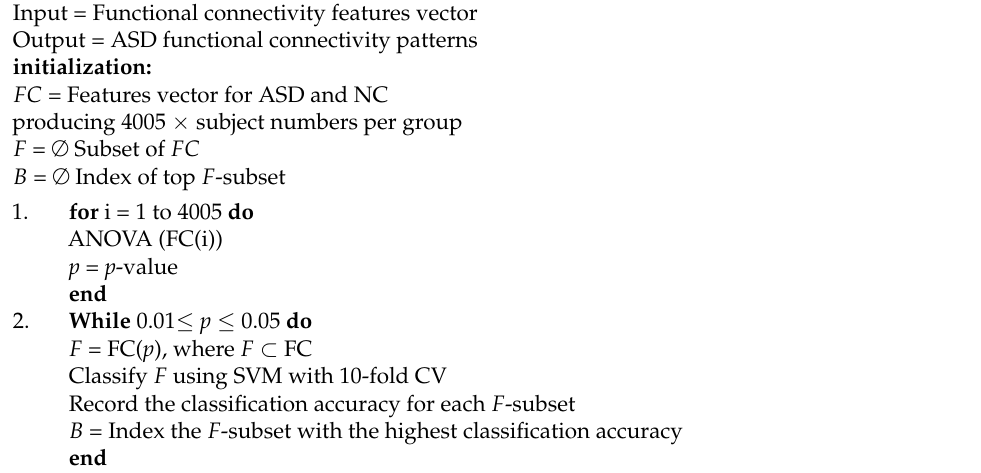
Algorithm 1 ANOVA-SVM method for finding the top subset of connectivity features for discrimi-